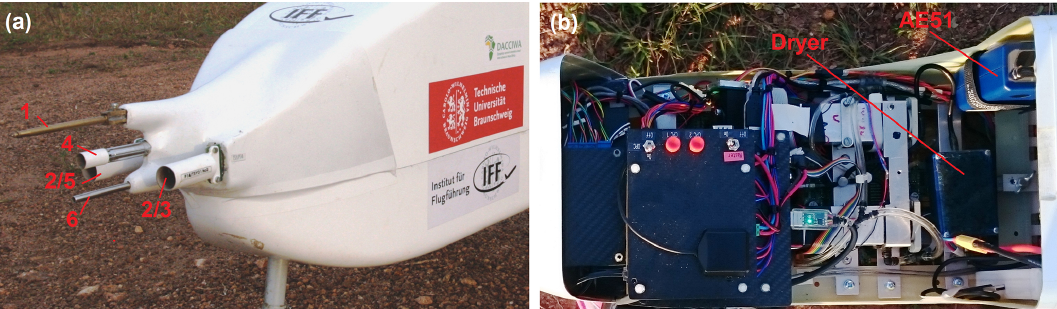
Figure 1. The pictures show the measurement units of the UAS ALADINA during DACCIWA in Savè. (a) The nose of ALADINA is equipped with meteorological sensors for calculating the three-dimensional wind vector with one multi-hole probe (number 1), temperature (number 2–4), and humidity (number 4 and 5). The air probe is sampled with one aerosol inlet (number 6) mounted at the tip of the aircraft’s nose. (b) The micro-aethalometer AE51 is installed in the front compartment of the aircraft for adjusting the centre of gravity. The airstream is dried with silica gel before measuring (see the blue box close to the AE51). Photo: Institute of Flight Guidance, TU